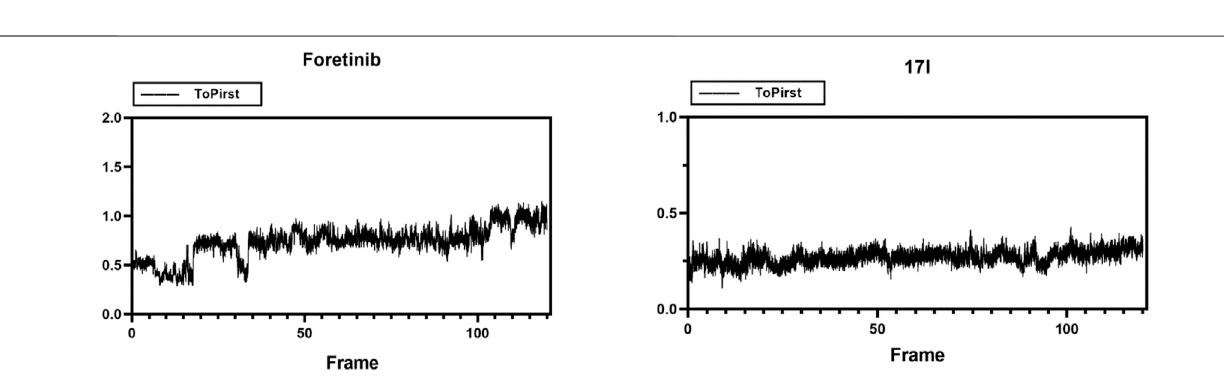
Frontiers in Chemistry |